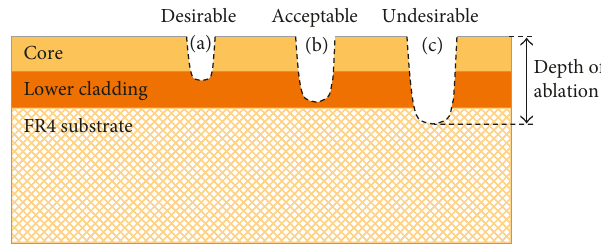
Figure 1: A schematic diagram showing three different types of ablation depths using laser beam with top-hat